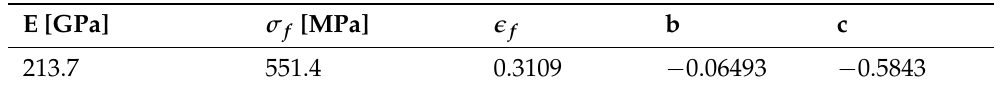
Table 3. Strain-life model’s